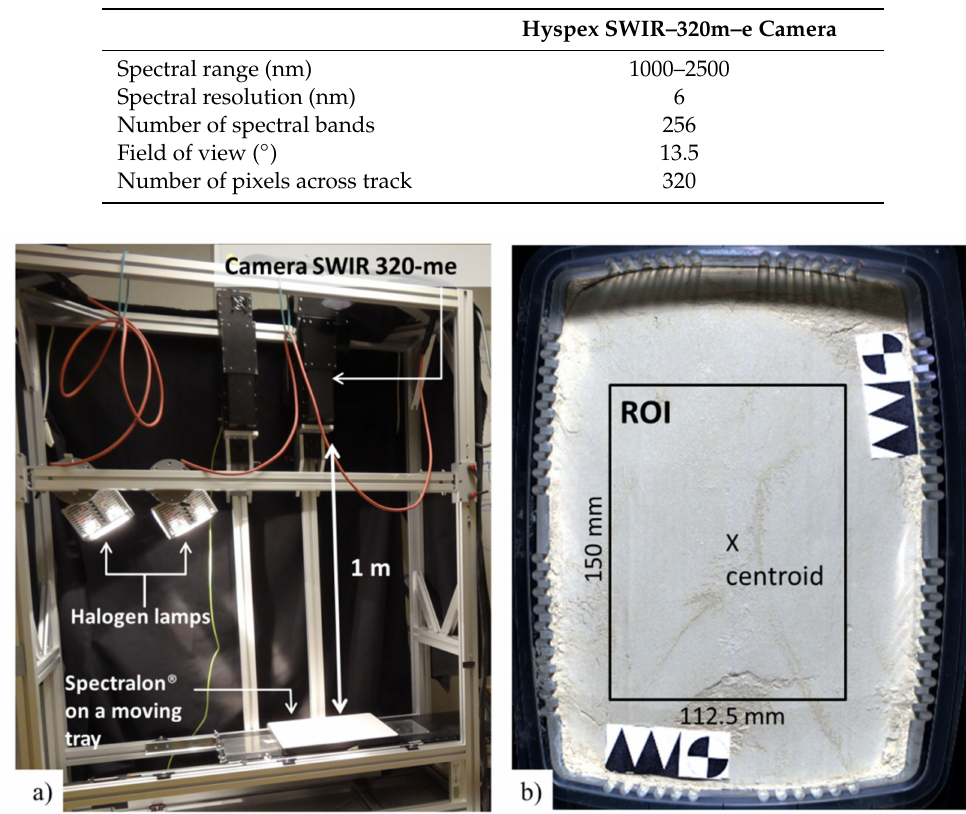
Table 1. Characteristics of the HySpex hyperspectral camera.